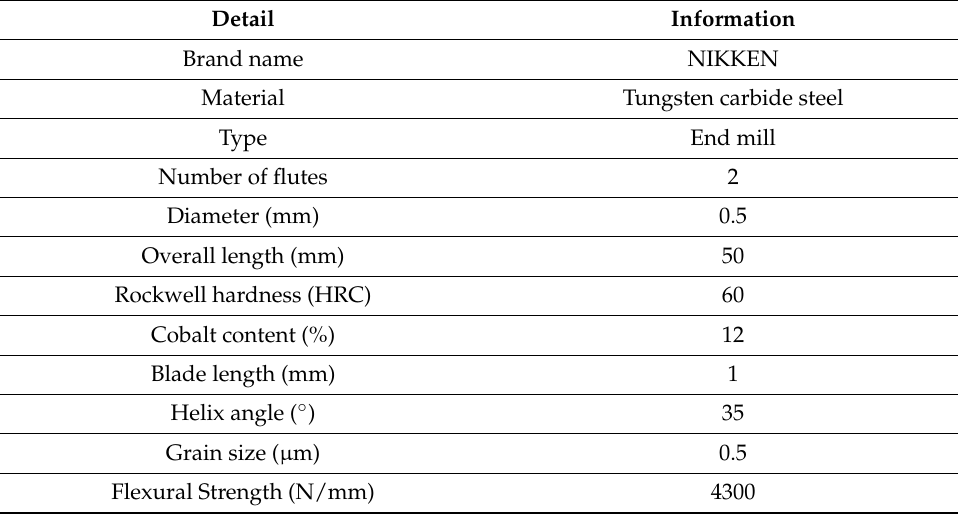
Table 5. Coatings specification used in the